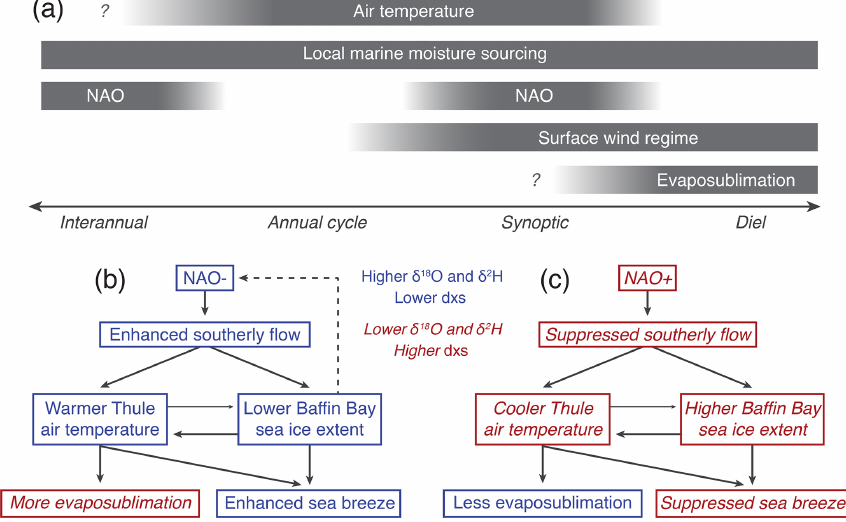
Figure 5. Summary of effects of environmental factors affecting water vapor isotope composition at Thule. (a) Illustration of temporal scales when each factor is most impactful. Question marks indicate periods of an uncertain degree of impact. (b) Interactions between environmental factors during NAO conditions, with factors that produce higher δ 18 O and δ 2 H values and lower dxs values in blue, and factors that produce lower δ 18 O and δ 2 H values and higher dxs values in italicized red. The dashed line refers to the possibility that a low sea ice extent reinforces the NAO phase (e.g., Petrie et al., 2015). (c) Same as (b) but for NAO +